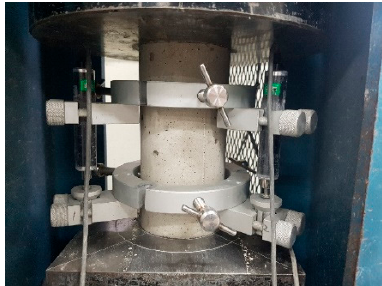
Figure 1. Experimental setup for static destructive test.